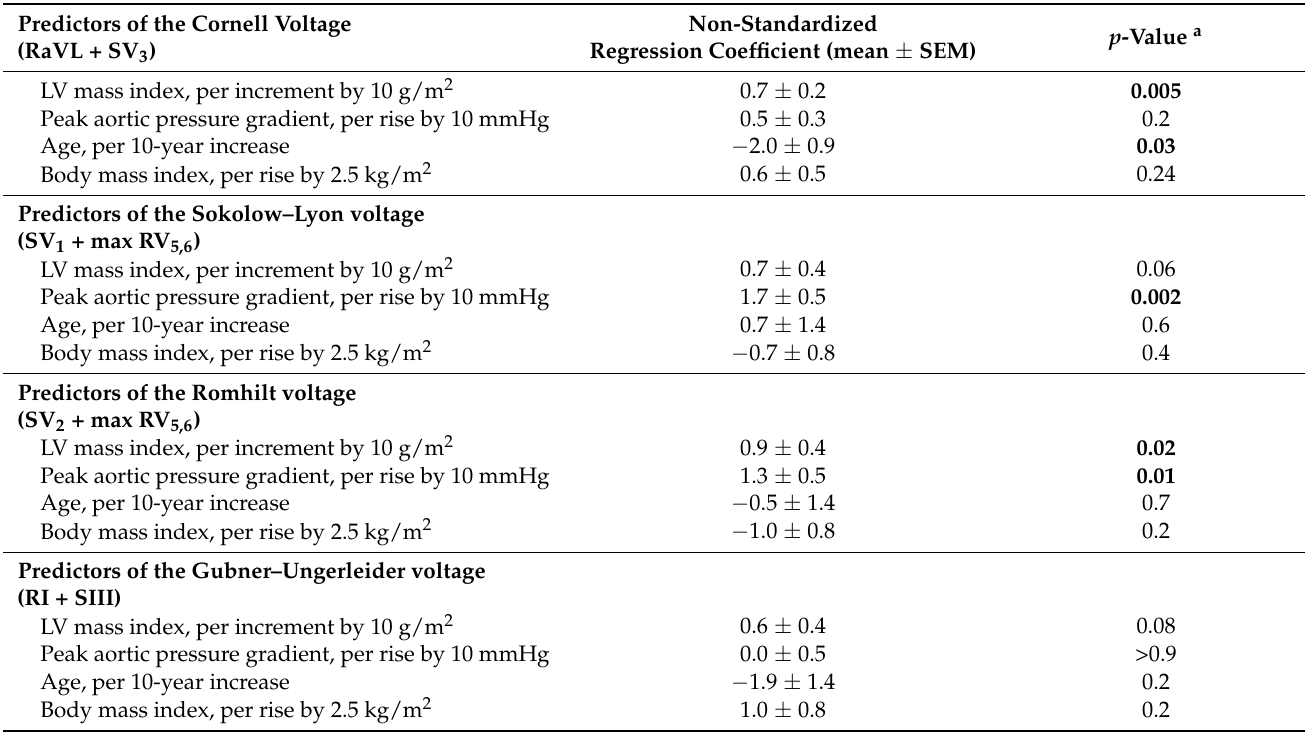
Table 4. Multiple regression analysis of predictors associated with the Cornell, Sokolow–Lyon, Romhilt and Gubner– Ungerleider voltage criteria for LVH with LV mass indexed to body-surface area.